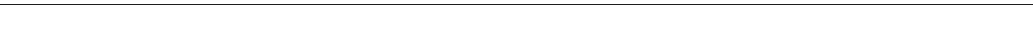
Fig. 3 Mutant clone size distributions in human epidermis. a , b Clone size distribution for all mutations identi fi ed in the 10 patients in the study. Unnormalised variant allele fraction (VAF) is plotted against the fi rst incomplete moment on standard ( c ) and log ( d ) scale. c , d Clone size distribution for synonymous SNVs. Unnormalised variant allele fraction (VAF) is plotted against the fi rst incomplete moment on standard ( e ) and log ( f ) scale. e , f Clone size distribution for nonsynonymous SNVs, frameshift mutations and splicing mutations. Unnormalised variant allele fraction (VAF) is plotted against the